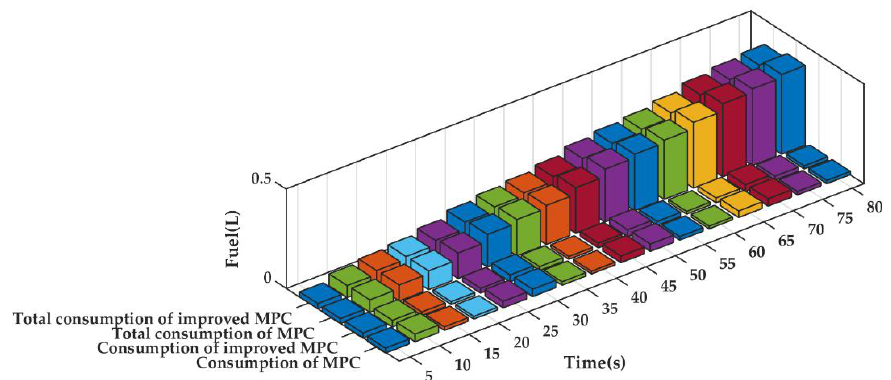
Figure 23. The fuel consumption in Scenario 2.